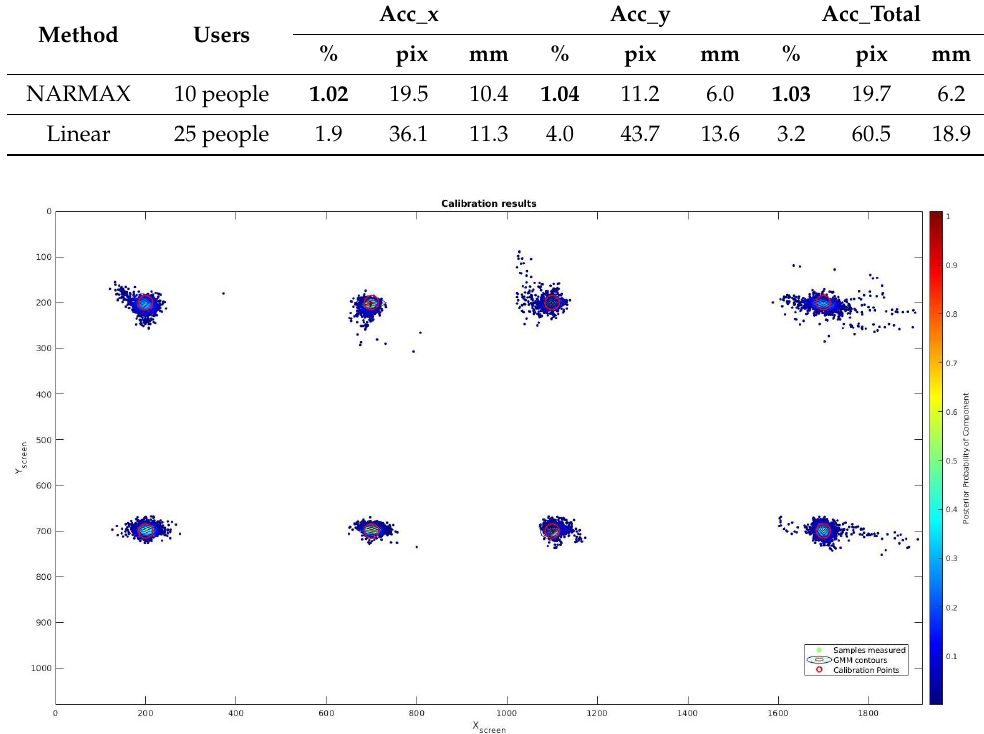
Figure 4. Calibration results using NARMAX calibration method. Eight points are displayed on the screen (Red circle). The results from our output creates 8 Gaussian around the testing points.